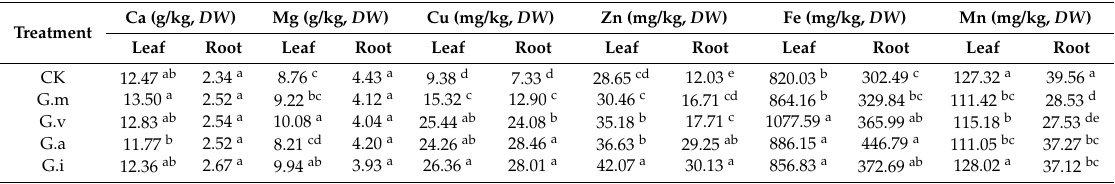
Table 6. Effect of AMFs on Ca, Mg, Cu, Zn and Mn concentration of S. miltiorrhiza seedlings.